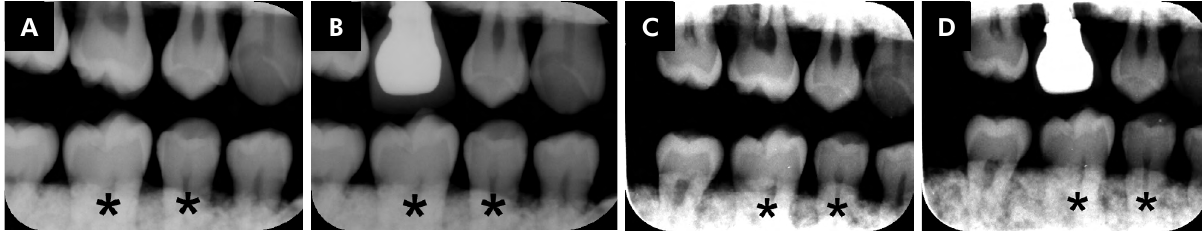
Figure 3. Bitewing digital radiographs obtained with the Digora Toto (A and B) and Digora Optime (C and D), in the absence (A and C) and presence (B and D) of high-density material. Asterisks indicate the test teeth.